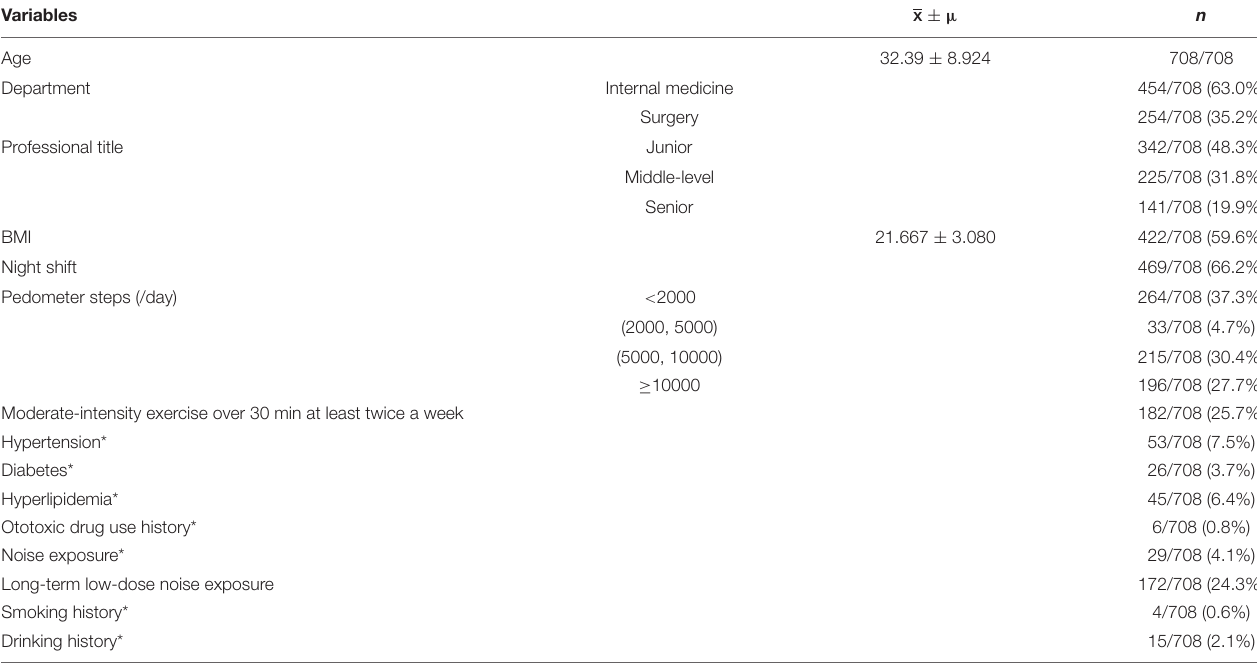
TABLE 1 | Epidemiological characteristics of 708